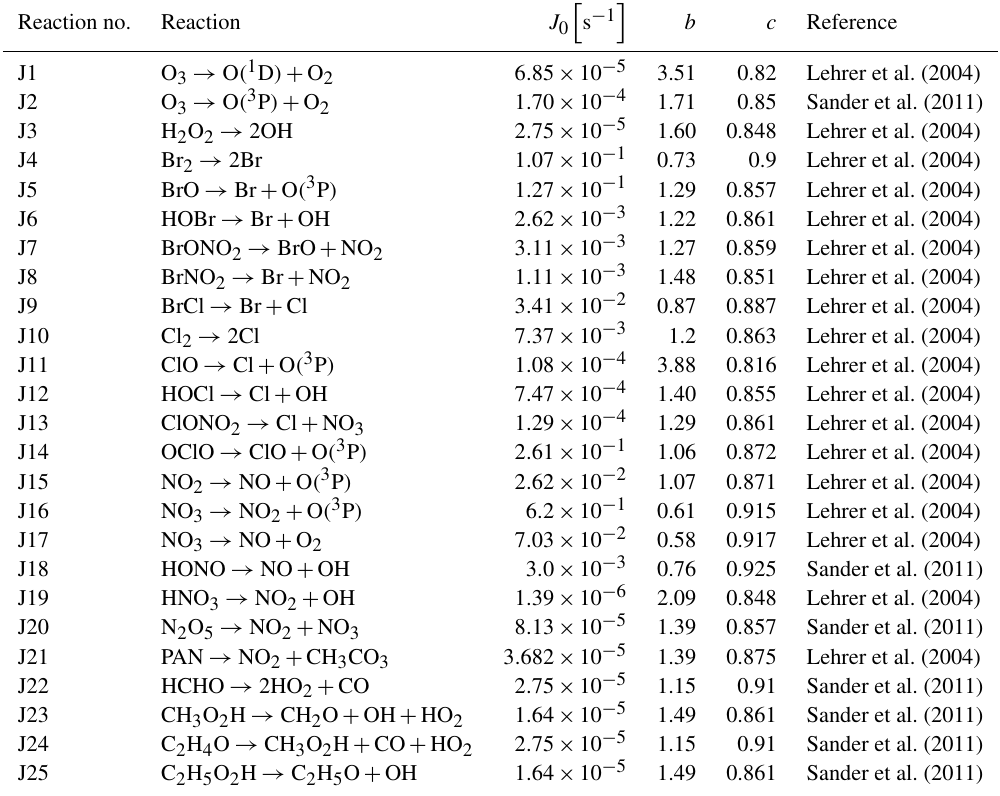
Table A2. Photolysis reactions.